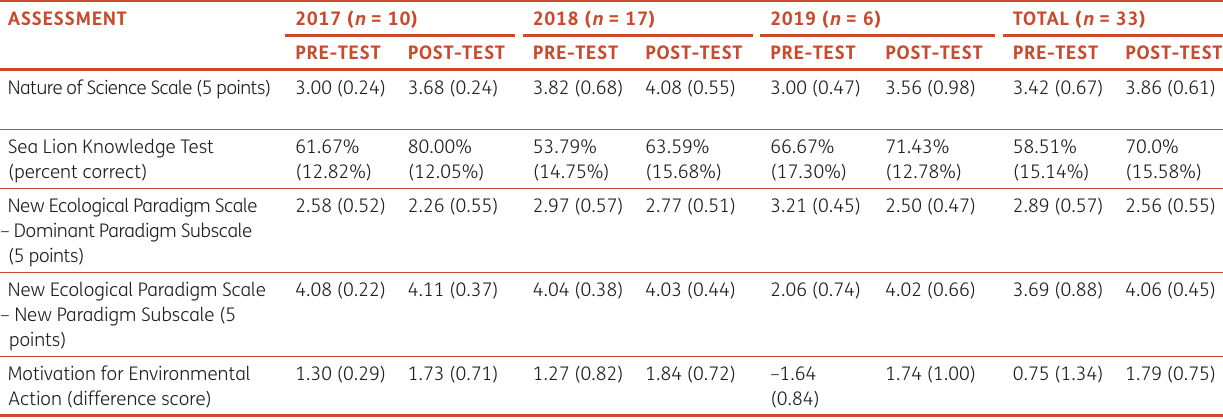
Table 1 Participants’ average performance on the quantitative assessments, across years. Note : Standard deviations are in